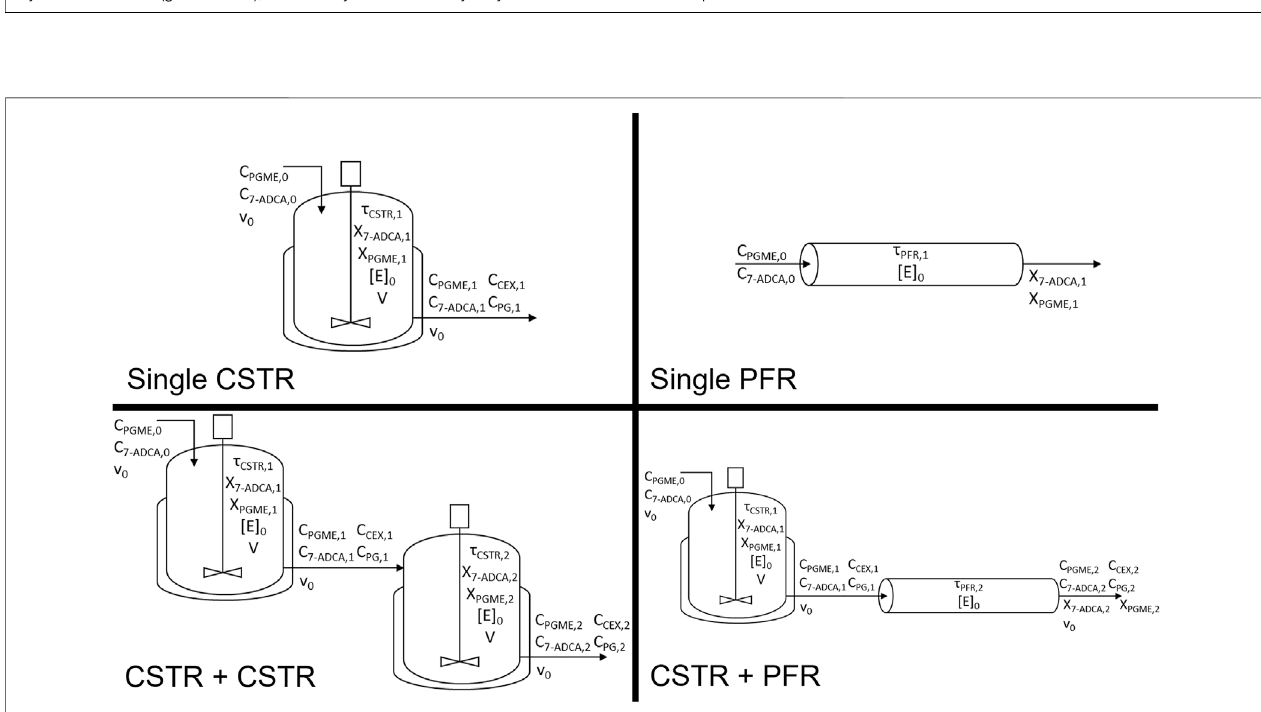
FIGURE 1 | Reactor con fi gurations simulated and corresponding variables tracked for each system. Reactor con fi gurations include a single CSTR, single PFR, CSTR + CSTR, and a CSTR + PFR.